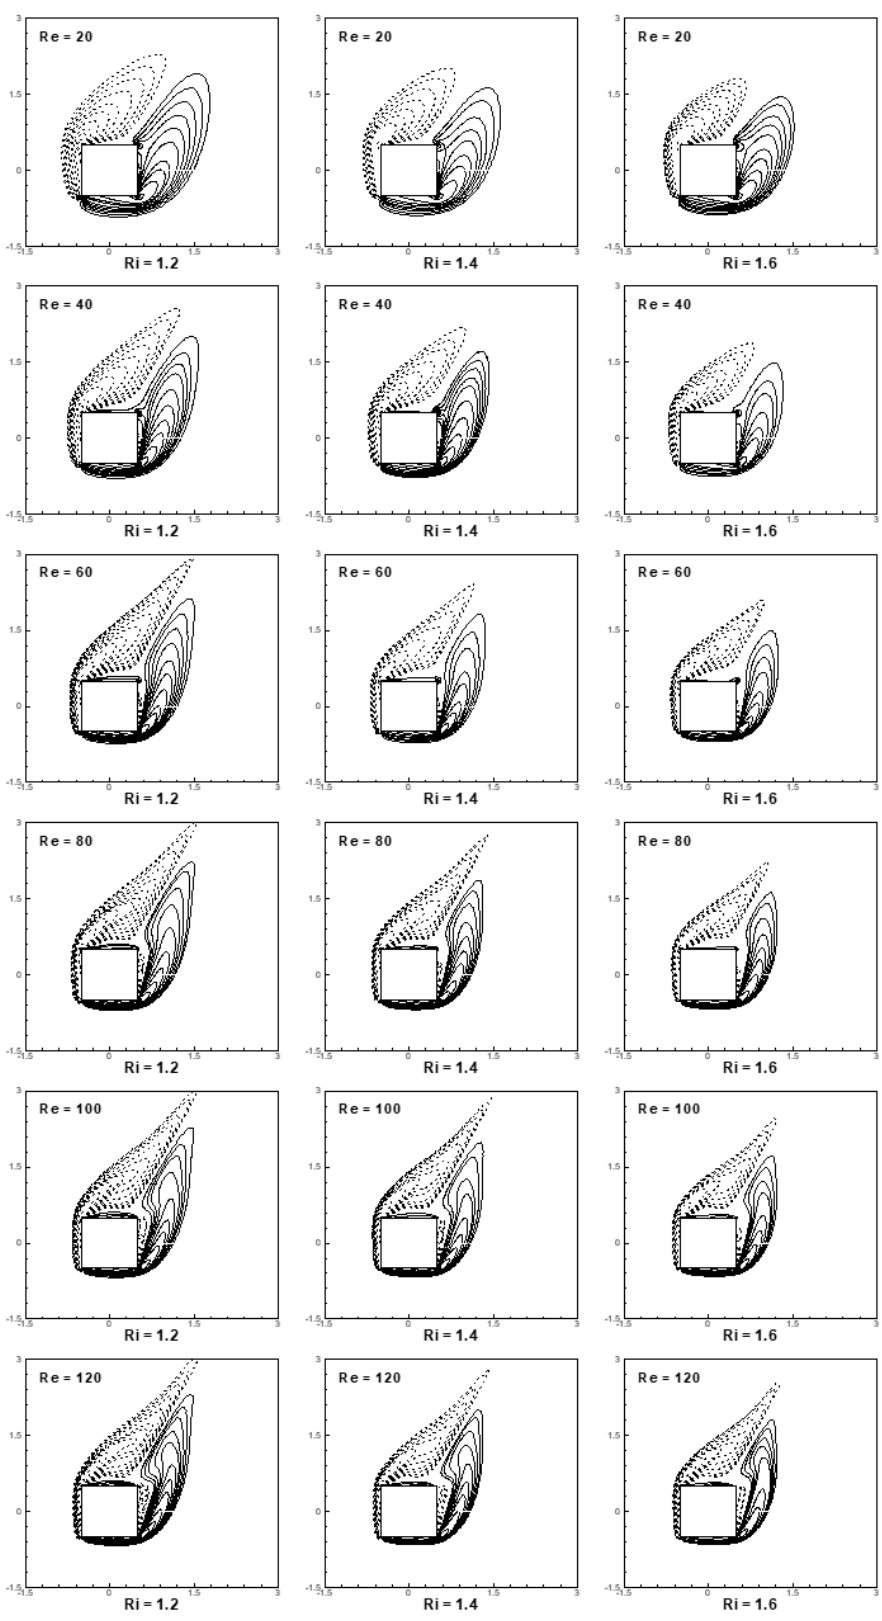
Figure 10. Steady state contours of vorticity for (20 ≤ Re ≤ 120 and 1.2 ≤ Ri ≤ 1.6) at α = 30 ◦